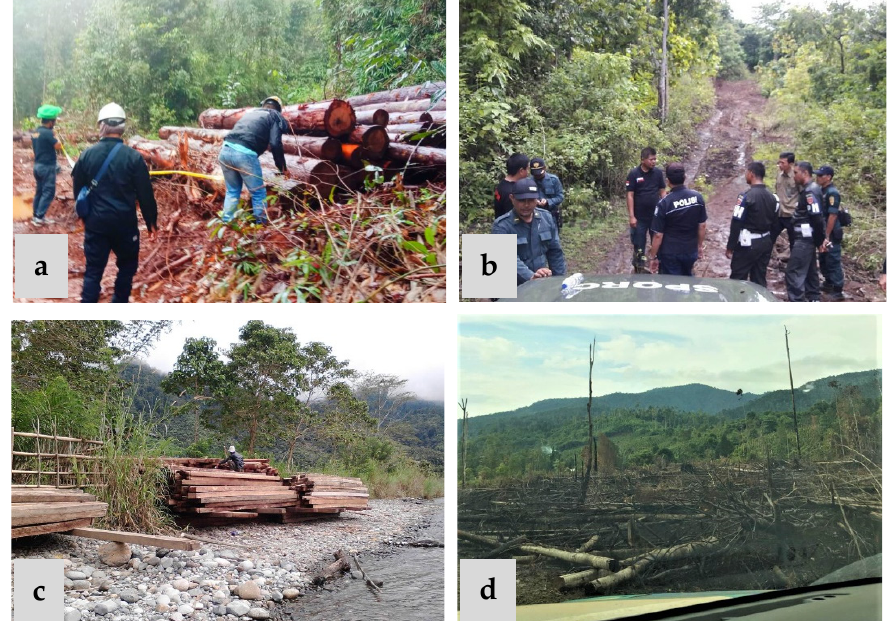
Figure 7. Distribution map of illegal logging events in Sulawesi Selatan in 2021.